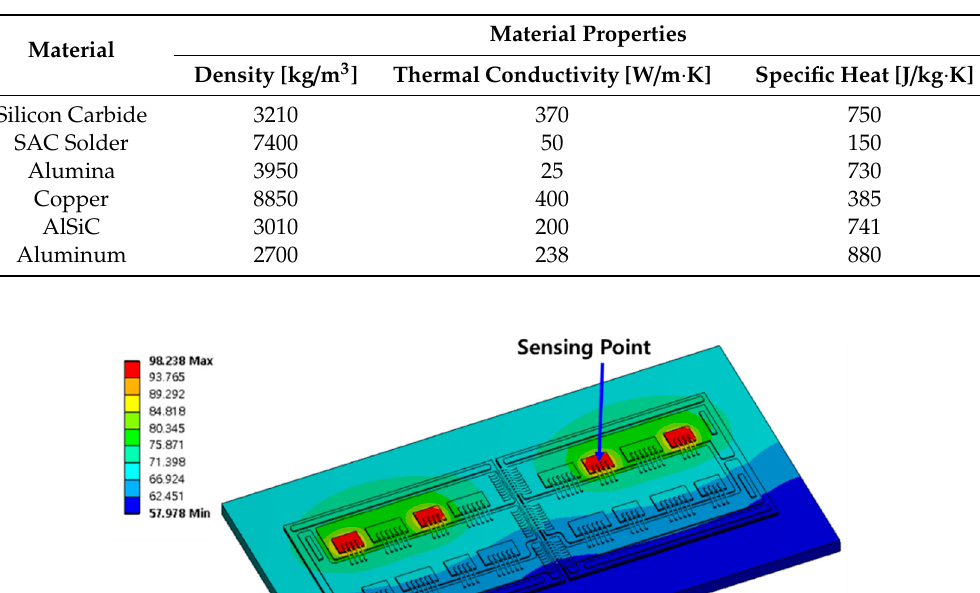
Table 3. Material Properties in the finite-element method (FEM) simulation [28–30].